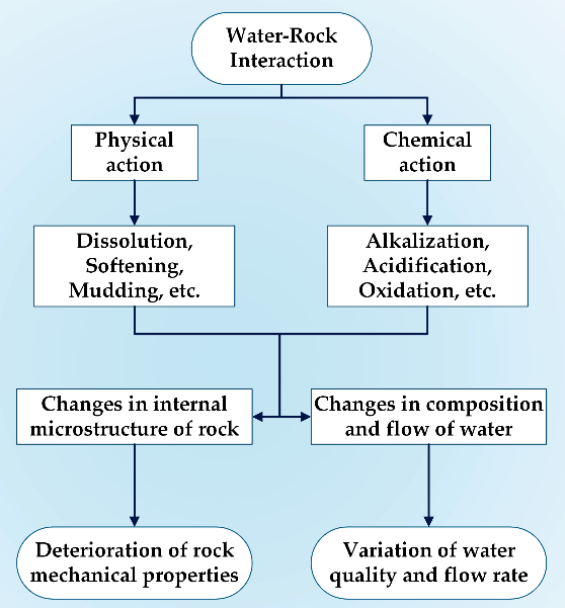
Figure 8. The schematic diagram of the water–rock interaction process.